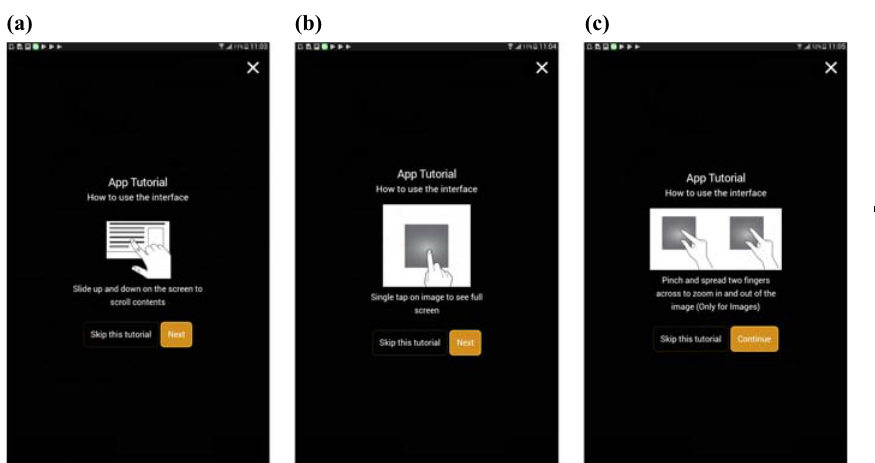
Figure 4. Animated Instructions proving study guidance on how to